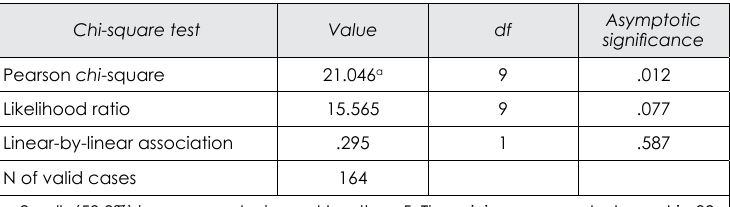
Table 11: Projects undertaken using BIM versus greater